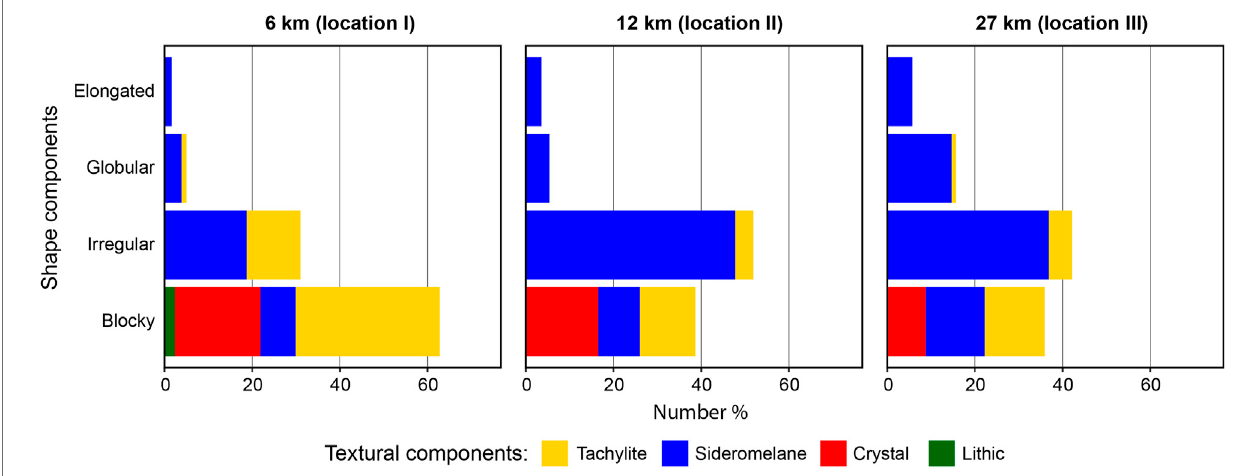
FIGURE4| Componentryofthe125 – 180 µmashfractionatlocationsI(6 kmfromvent),II(12 kmfromvent)andIII(27 kmfromvent),intermsofbothmorphology and textural types. Data represented in number %.